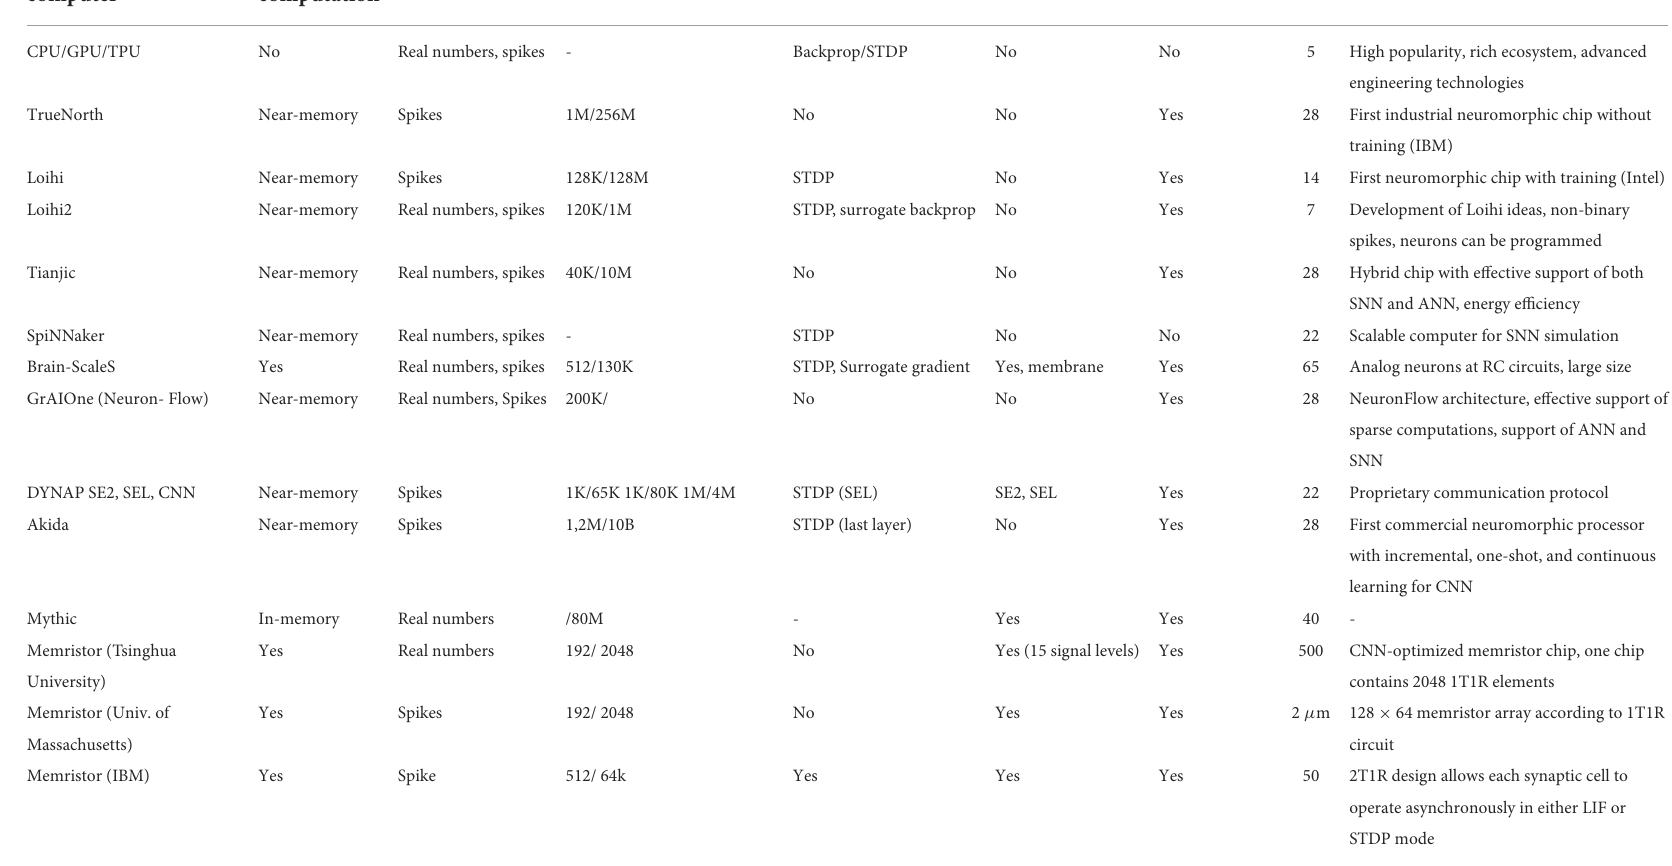
TABLE 3 Comparison of neuromorphic